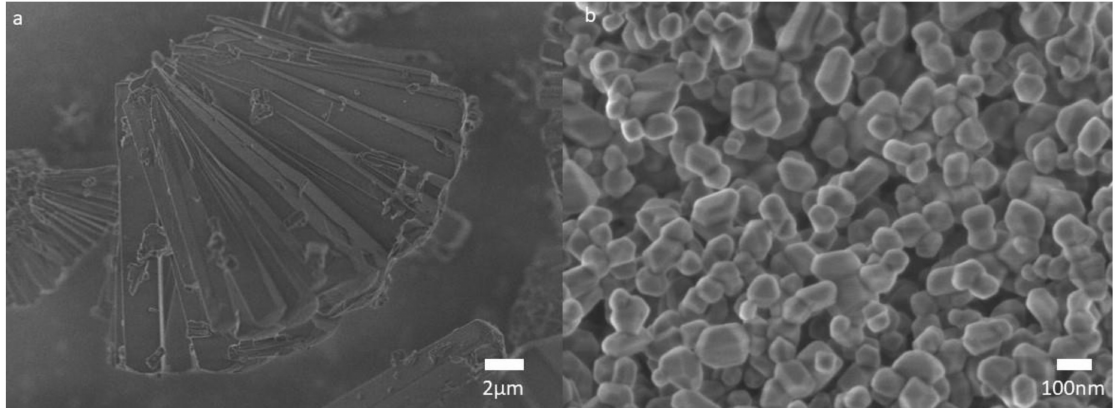
Figure 2. Scanning electron microscopies of ( a ) the precursor microparticles and ( b ) the resulting MgO nanoparticles after the calcination at 800 ◦ C.